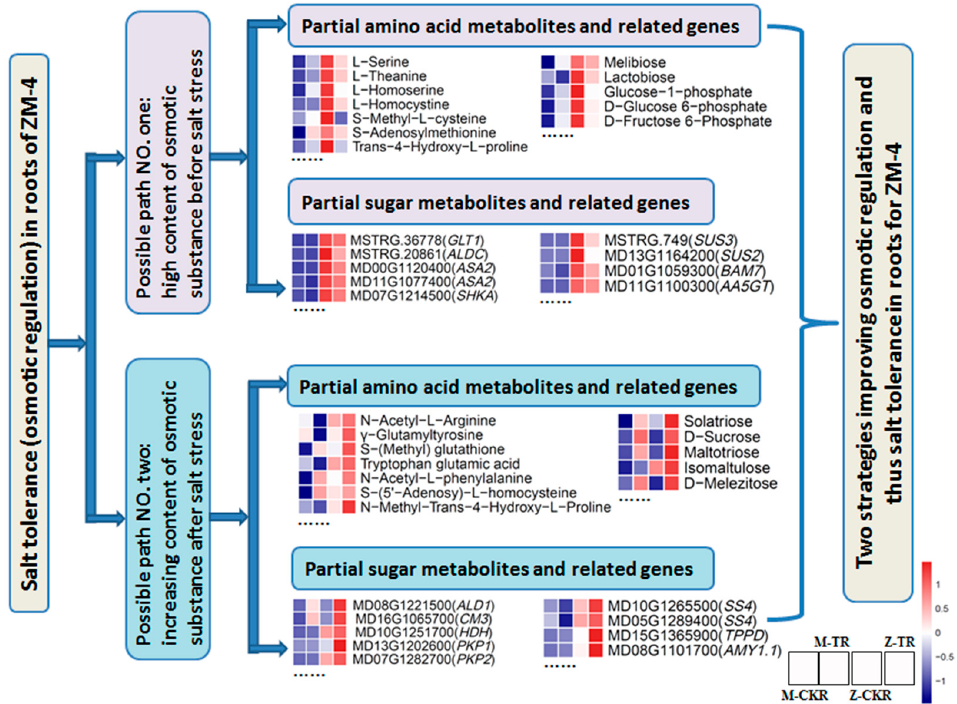
Figure 11. The possible paths of salt stress tolerance in the roots of ZM-4. (Ellipsis indicates the presence of other substances or genes that are not listed).